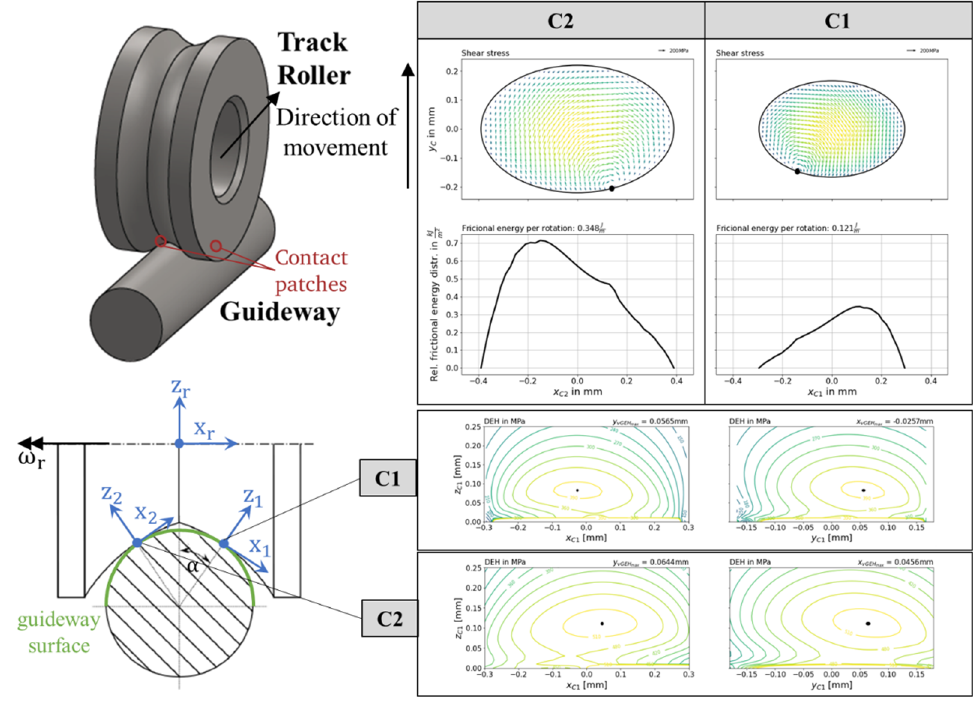
Figure 6. Overview of the output graphical results with additional explanations.